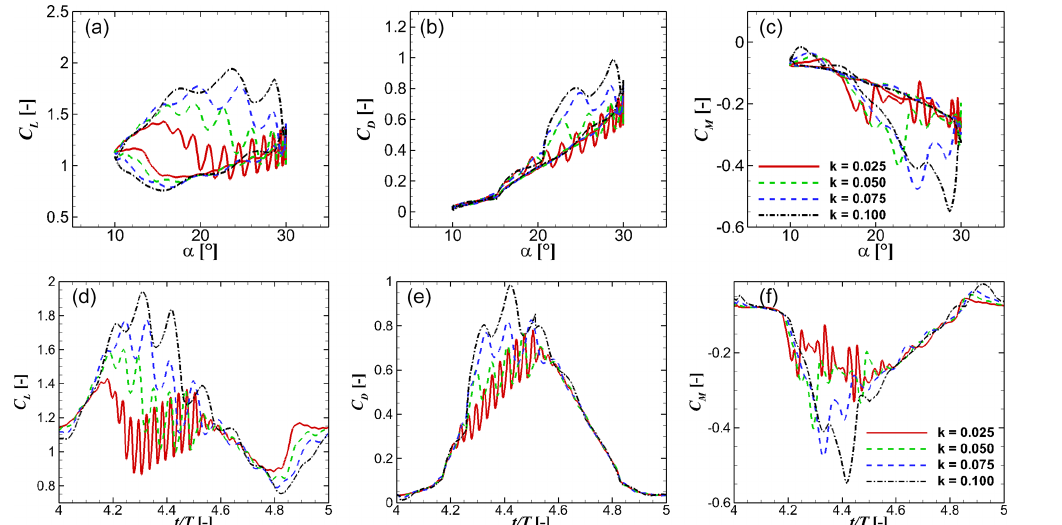
Figure 18. Effects of k on the aerodynamic response by the IAG model for (cid:49)t = T/ 1440. S801 airfoil, α = 20 and (cid:49)α = 10 ◦ . (a–c) Polar; (d–f) time series.